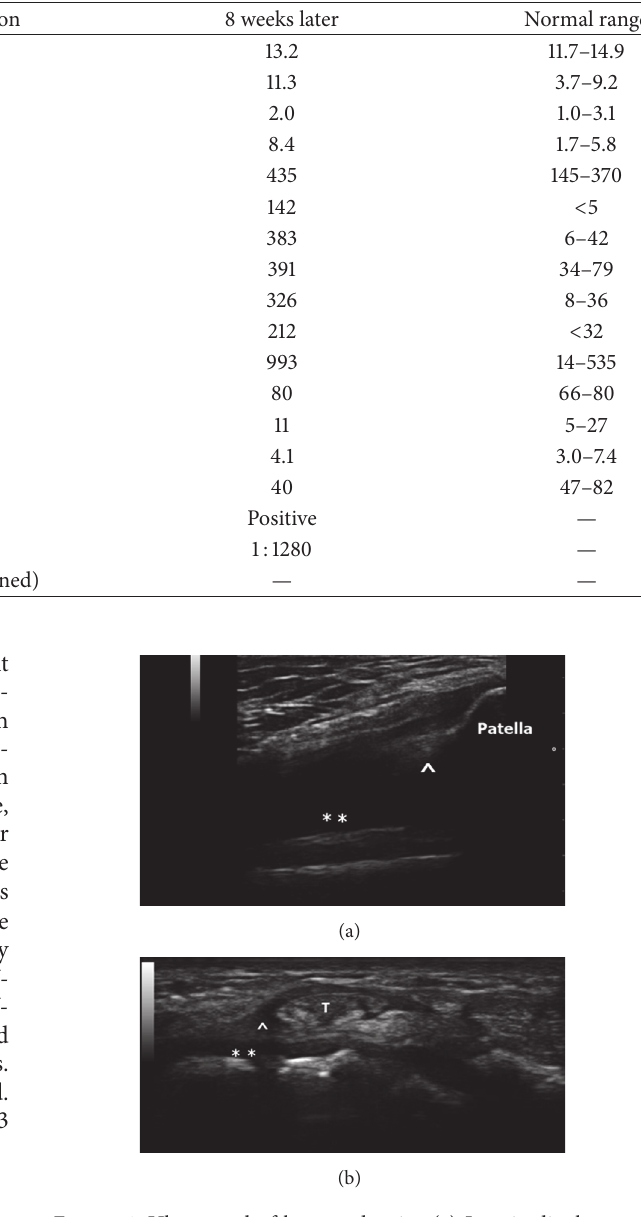
Figure 1: Ultrasound of knee and wrist. (a) Longitudinal scan of knee demonstrated hypoechoic joint fluid ( ∗∗ ) and synovial hyper- trophy ( ∧ ) at suprapatellar recess. (b) Transverse scan of dorsum of wrist showed hypoechoic effusion ( ∗∗ ) and rim of fluid compatible with tenosynovitis ( ∧ ) of extensor tendon